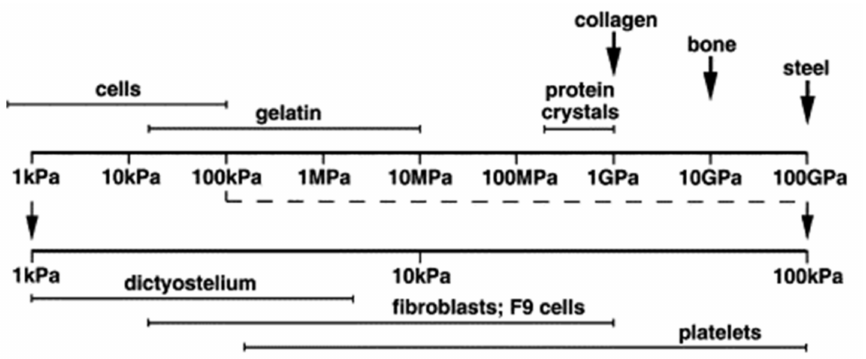
Figure 3. Elastic moduli of different biological and other materials. Reprinted from [15], Copyright (2003), with permission from